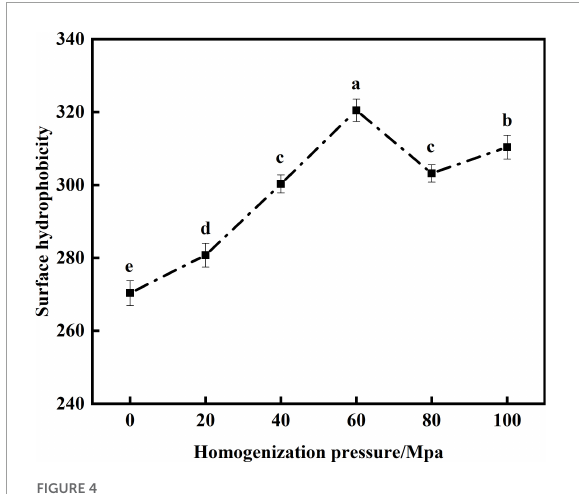
FIGURE4 Effects of high-pressure homogenization (HPH) on the H 0 of enzymatic hydrolyzed soybean protein concentrate (SPC).